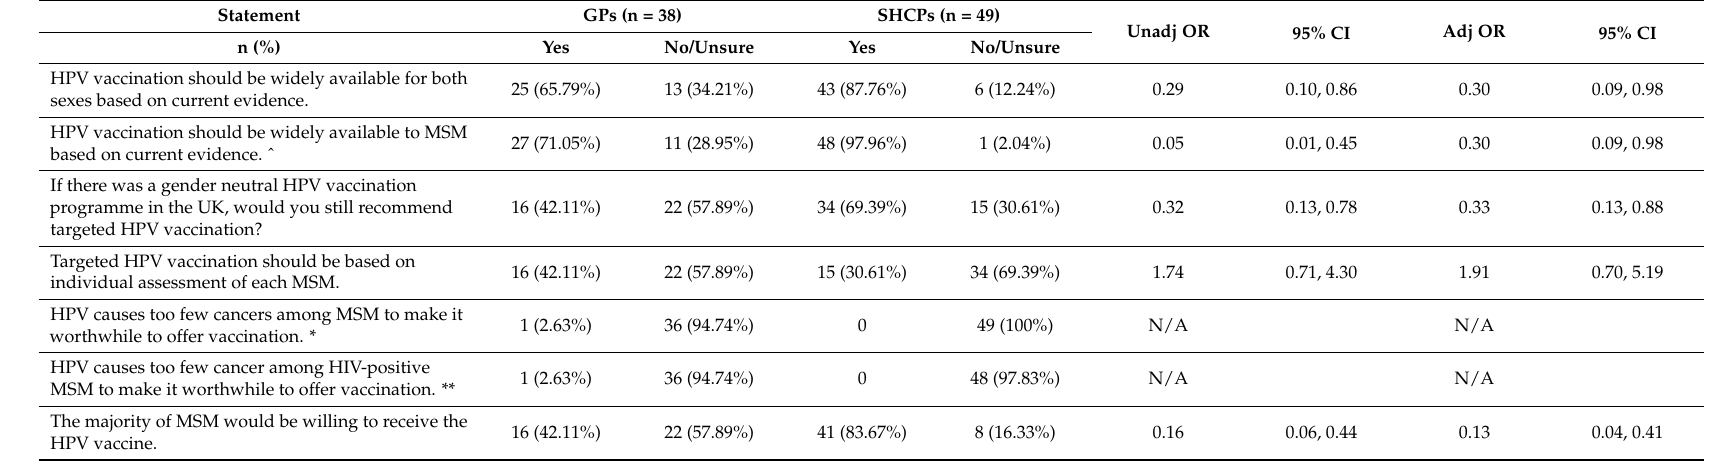
Table 3. GPs and SHCPs attitudes towards HPV vaccination for